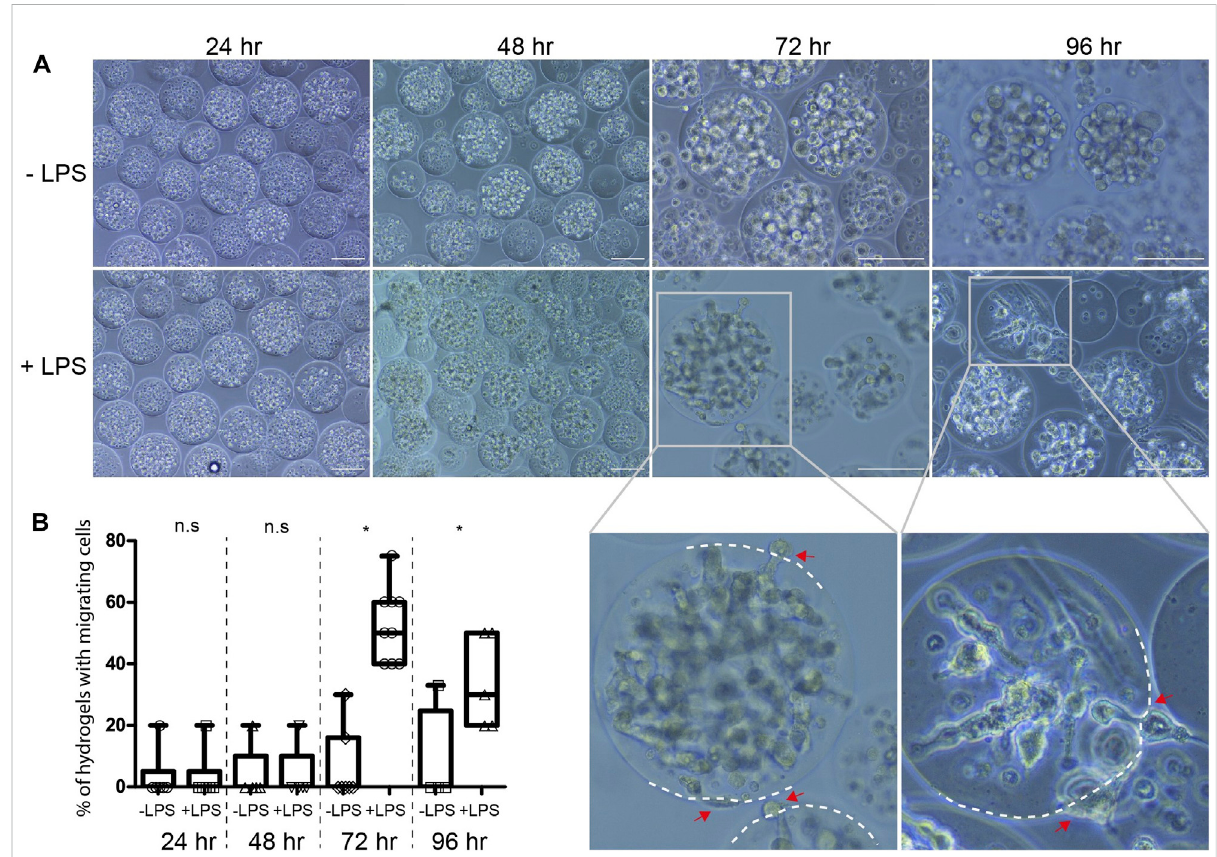
FIGURE 4 TheeffectofLPSoncellmigrationoutsidethemicrospheres (A) Bright fi eldimagesofencapsulatedmacrophagesthatwereLPS-exposedornot exposedoverthecourseof96 h.Scalebar100 µm.Magni fi edimagesshowcellmigrationoutsidethemicrospheremargins(markedindashedwhite lines). (B) Box plot showing percentiles of hydrogels with migrating cells calculated from six different images for each LPS or non-LPS exposed